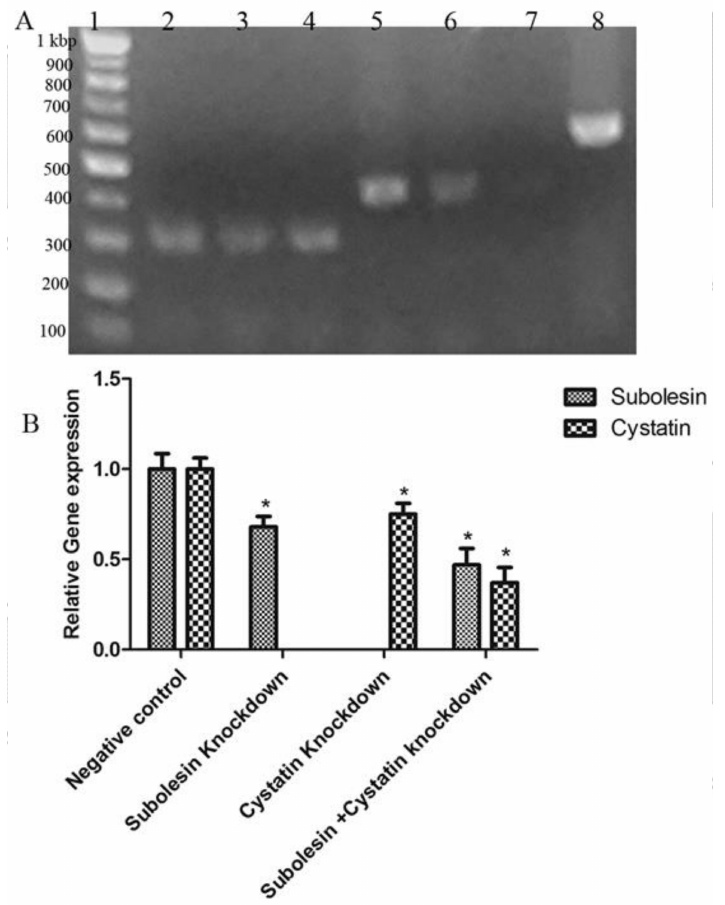
Figure 2. Quantitative and semi-quantitative RT-PCR showing knockdown of subolesin and cystatin by RNAi. ( A ) Semi-quantitative RT-PCR. Lane 1: 100 bp DNA ladder; lanes 2 to:, cystatin from the salivary glands (lane 2 was cystatin from subolesin + cystatin, lane 3 was cystatin from cystatin, and lane 4 was the control group); lanes 5 to 7: subolesin from the salivary glands (lane 5 was the control group, lane 6 was subolesin from subolesin + cystatin, and lane 7 was subolesin from subolesin ds RNA-treated group); and lane 8: actin used as an internal control; ( B ) Quantitative real-time RT-PCR showing subolesin, cystatin, subolesin + cystatin, and negative control ds RNA-treated messenger RNA levels. The data represent mean ± SD, normalized to the actin transcript level. The asterisk (*) denotes a significant difference in comparison with the control group, as determined by a Student’s t -test ( p <